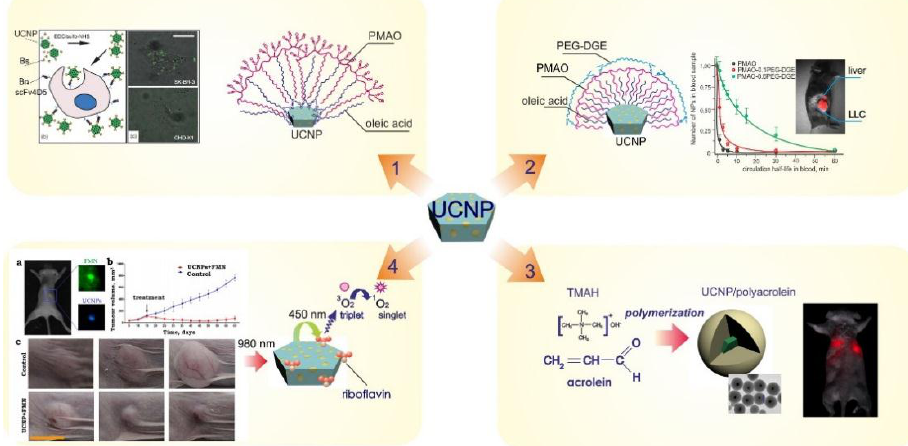
Fig. 1. Approaches of UCNP surface modification for various bioapplications